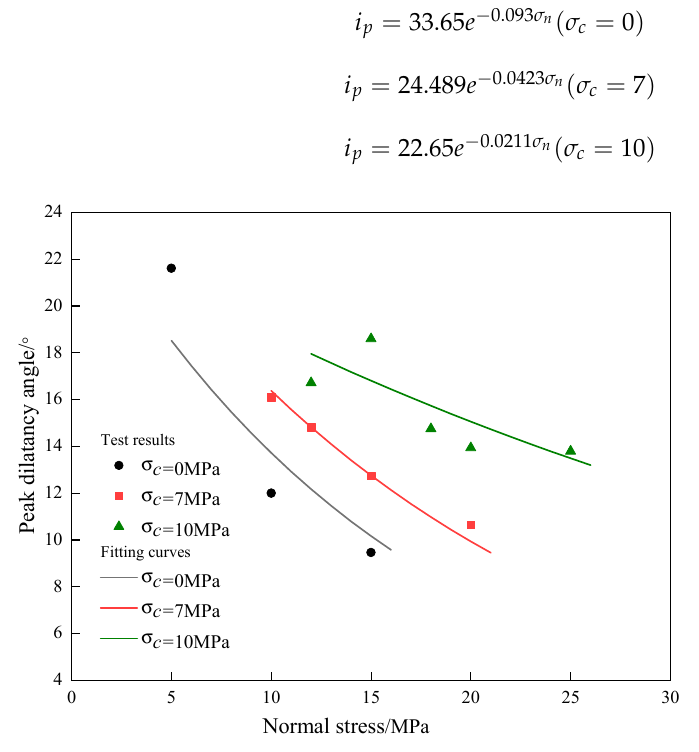
Figure 17. Comparison of the test and fitting results of the relationship between peak dilatancy angle and normal stress.